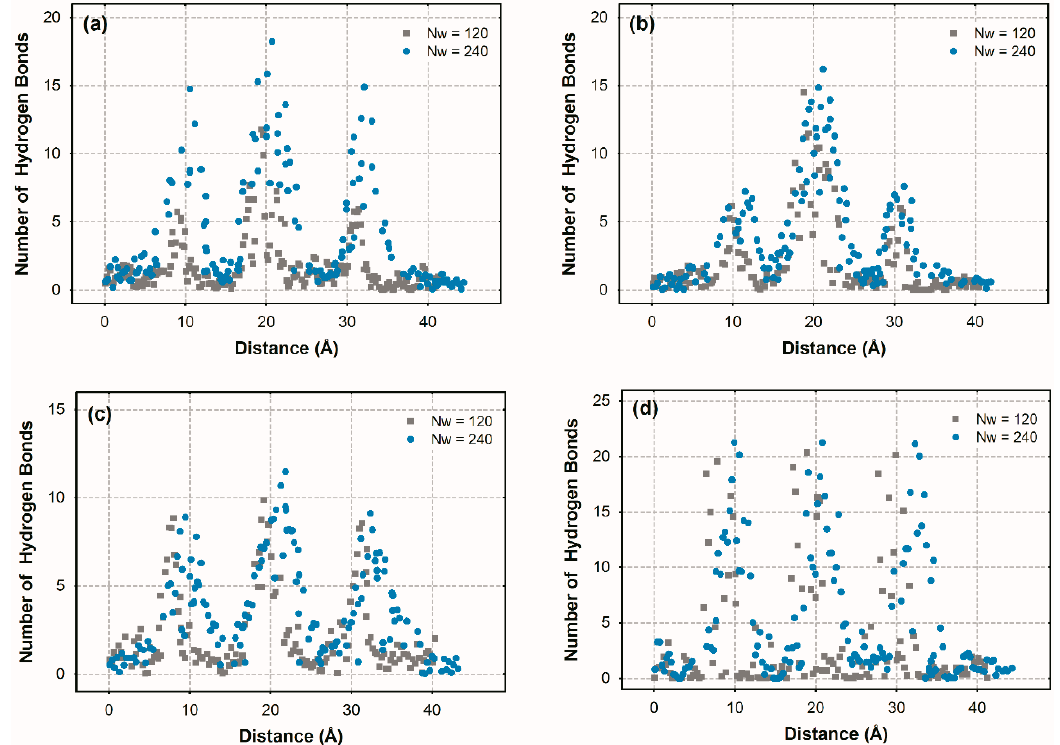
Figure 6. The number of hydrogen bonds along the cell z ‐ direction at the water content of 120 (gray) and 240 (blue) for four types of clay; ( a ) I ‐ MMT with 50% Na + and 50% K + ; ( b ) I ‐ MMT with 25% Na + and 75% K + ; ( c ) I ‐ MMT with K + only; ( d ) MMT ‐ MMT with Na + only.